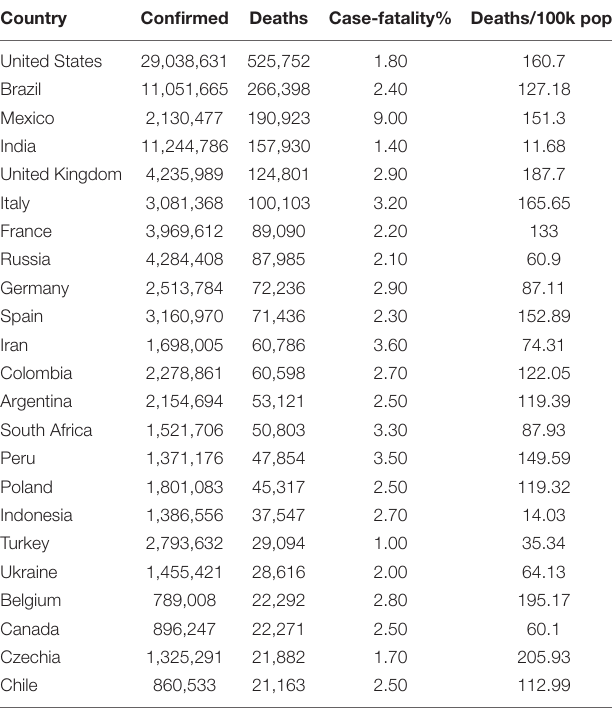
TABLE 2 | Cases with COVID-19’s mortality rate (Deaths), by March 9, 2021. Country Confirmed Deaths Case-fatality% Deaths/100k pop.